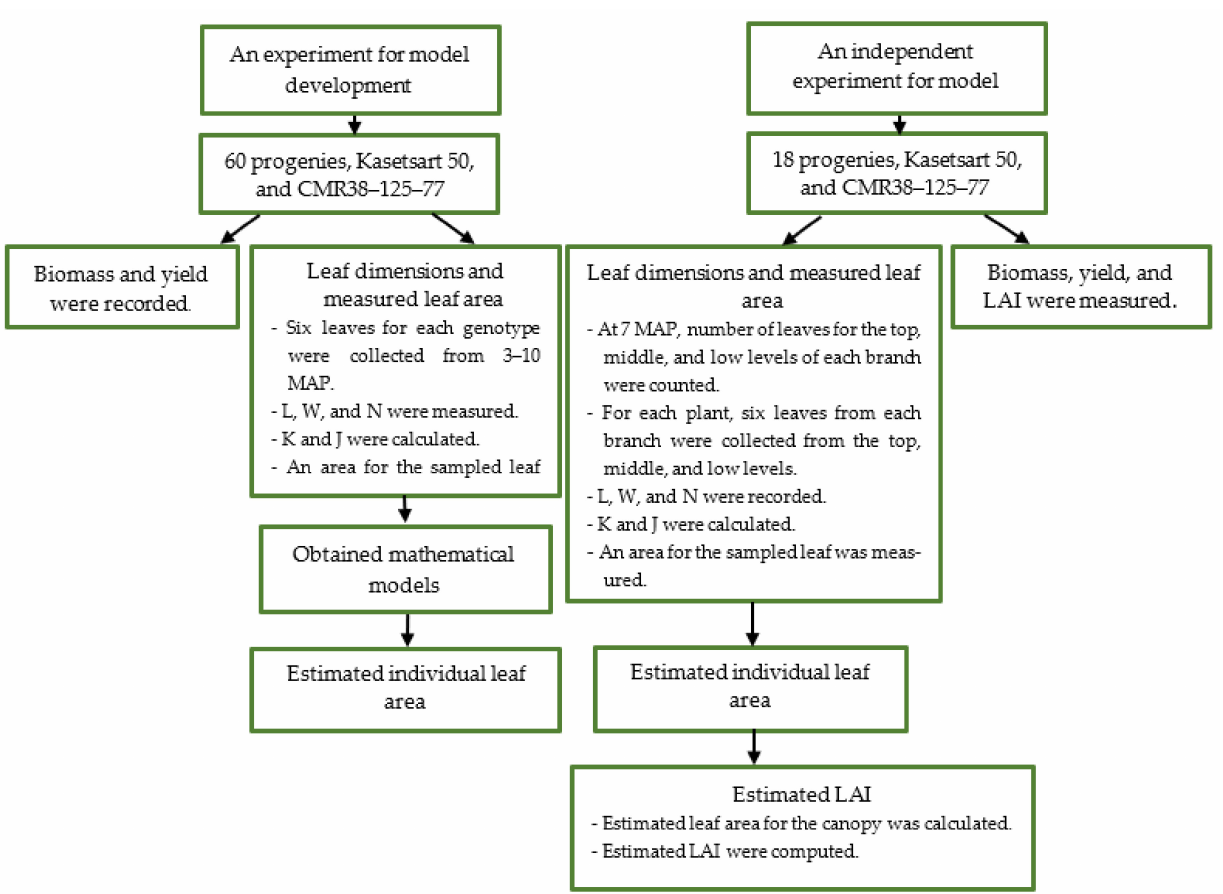
Figure 2. Diagram for the study process. L = length of the central lobe, W = width of the central lobe, N = number of lobes, K = product of length and width, J = product of length and number of lobes, LAI = leaf area